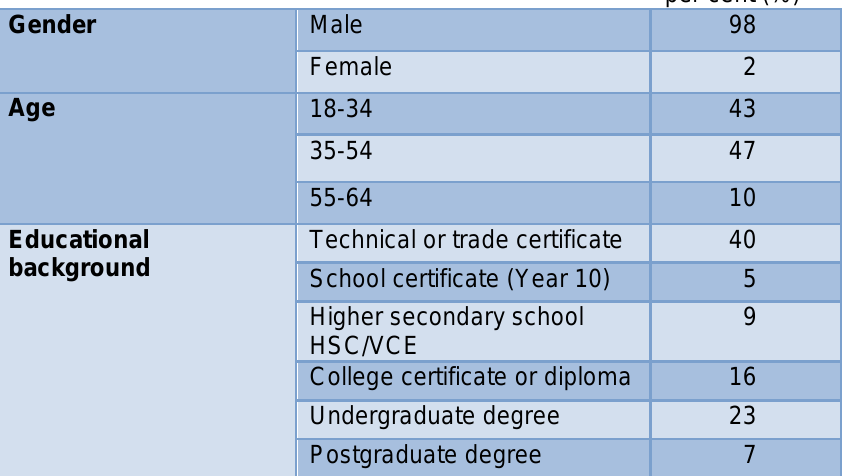
Table 2 Respondent demographics, Supervisors’ survey, Sydney construction sites,